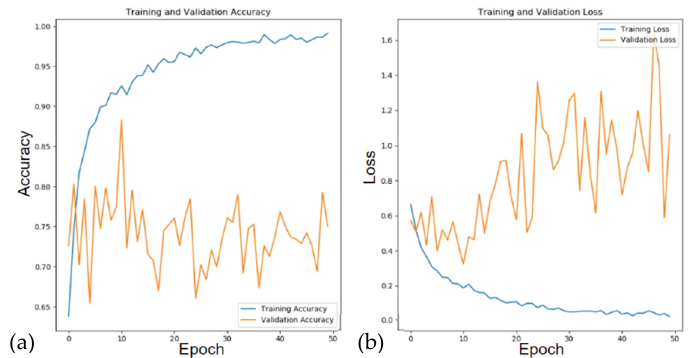
Figure 17. Peak accuracy of neural network predictions (a) and loss function (b).